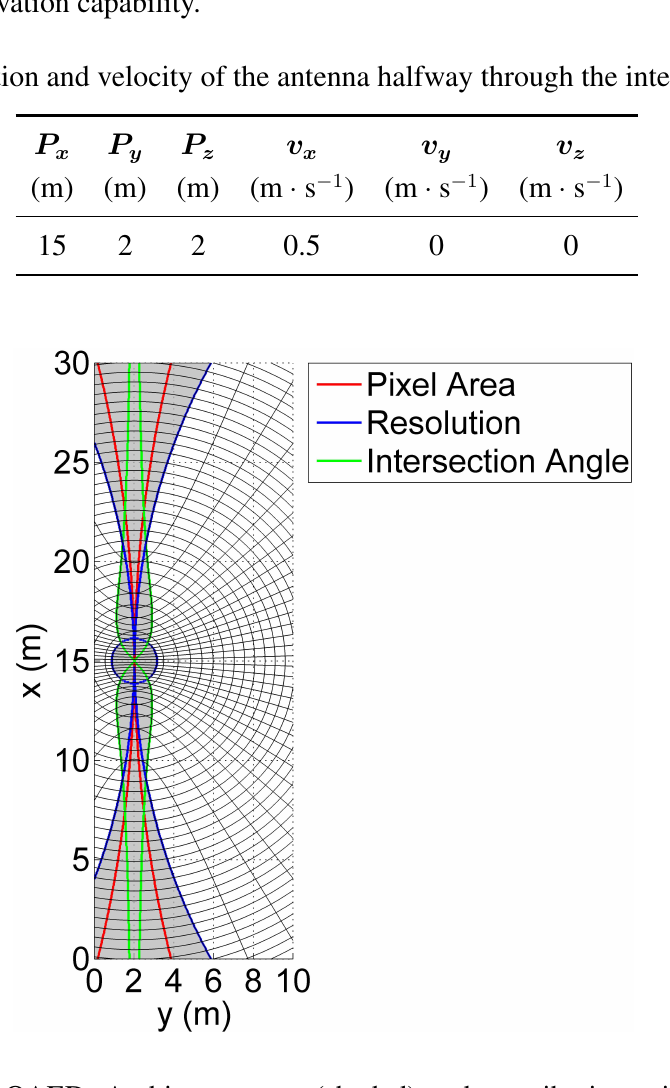
Figure 10. Plane OAED. Ambiguous area (shaded) and contributions: intersection angle (green contour), resolution (blue contour) and pixel size (red contour). For clarity, the distance between two close isolines does not represent the true system